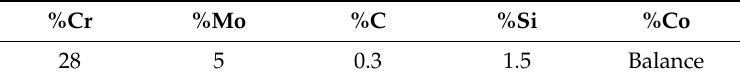
Table 1. Chemical composition of the studied cobalt alloy (wt.